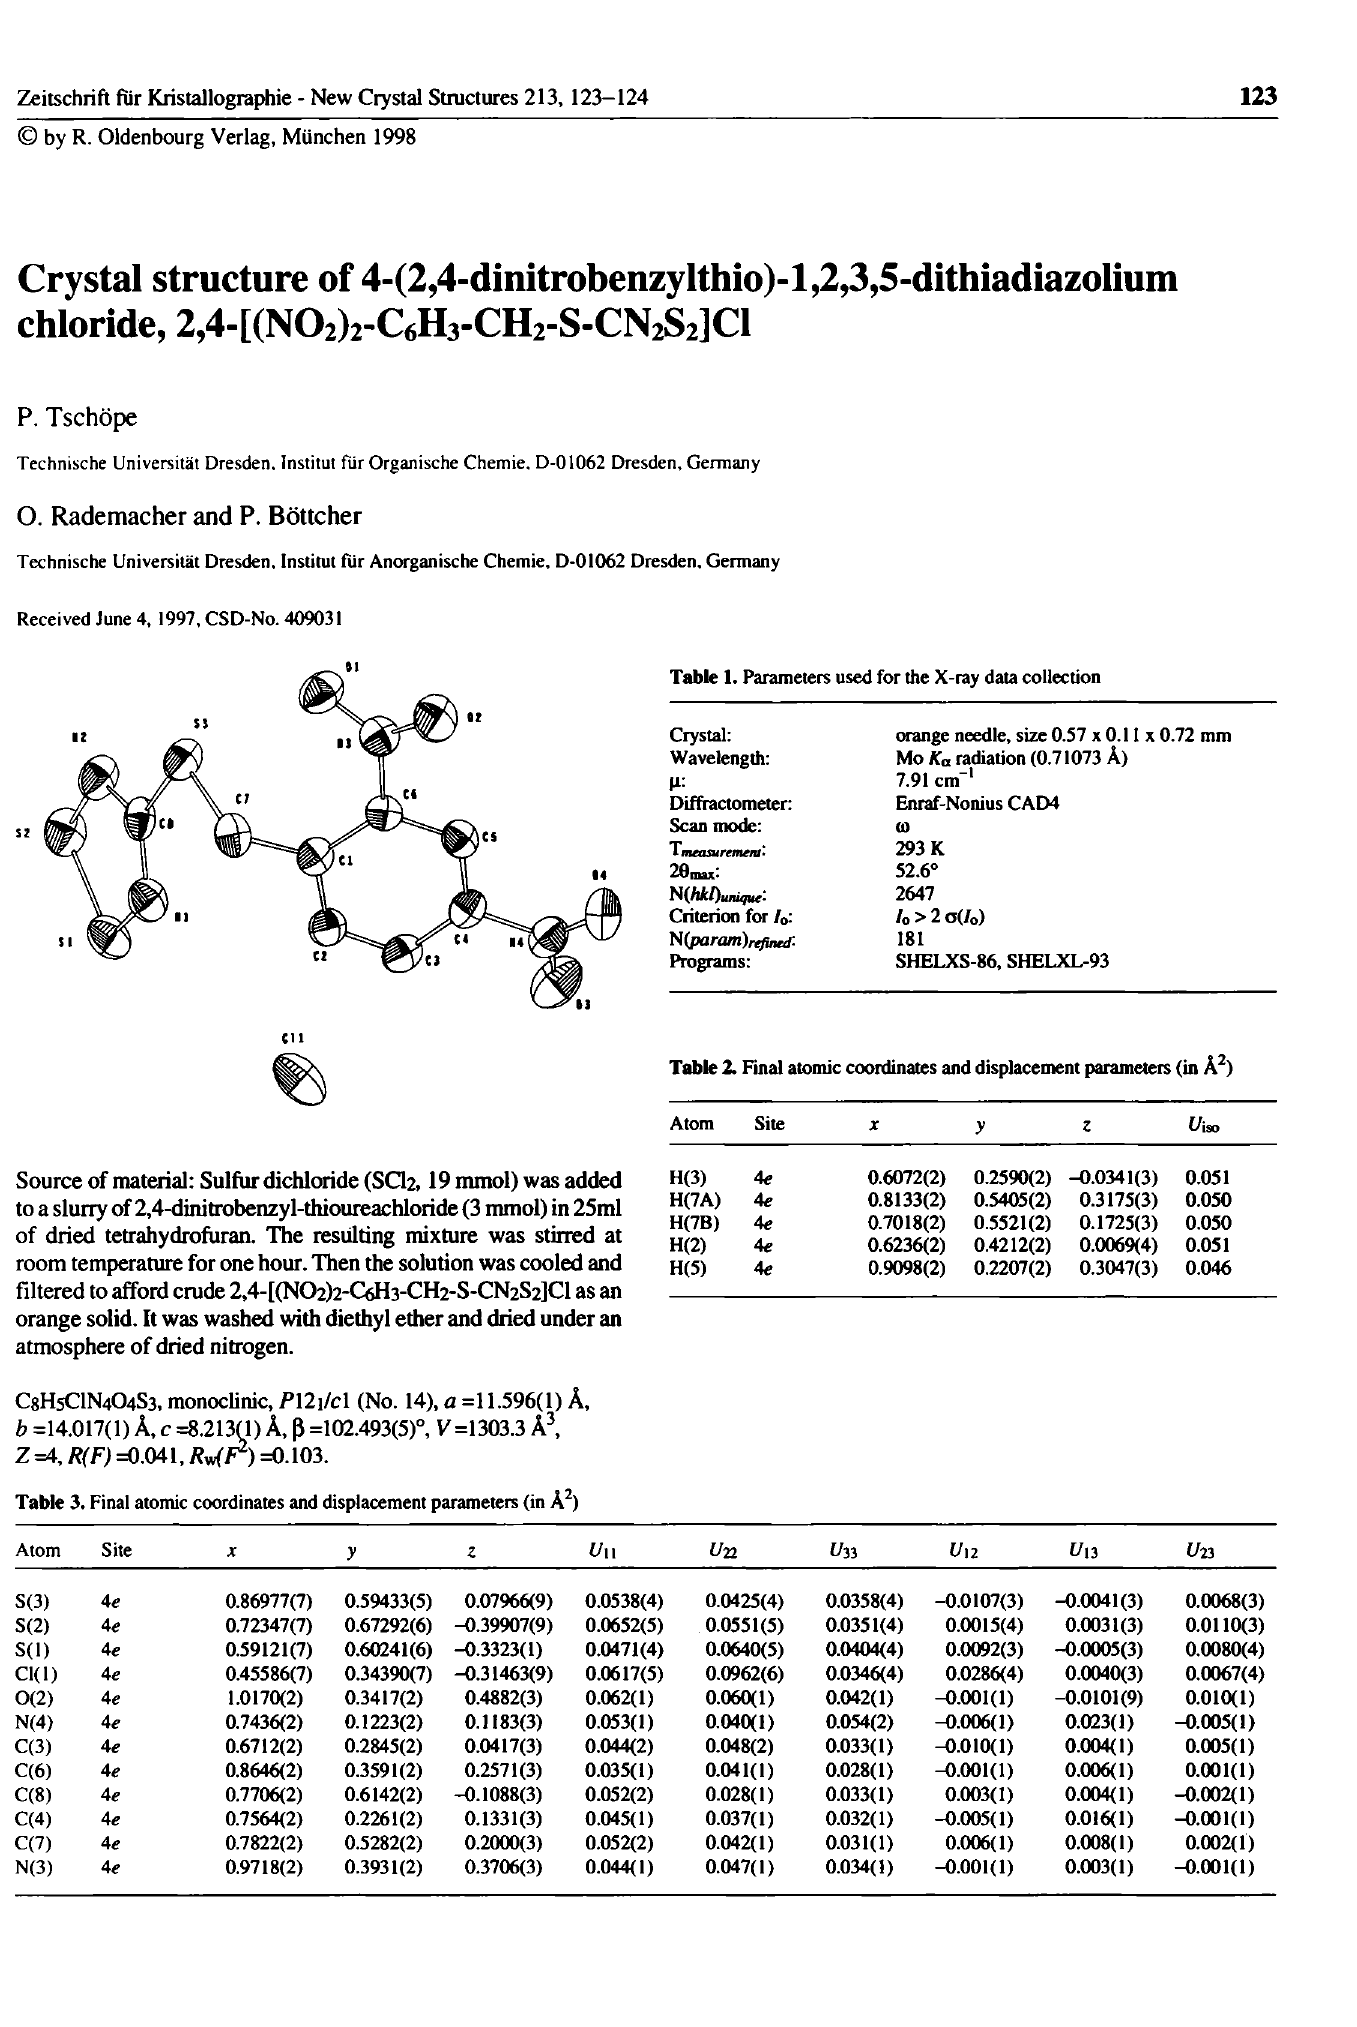
Table 1. Parameters used for the X-ray data collection Crystal: